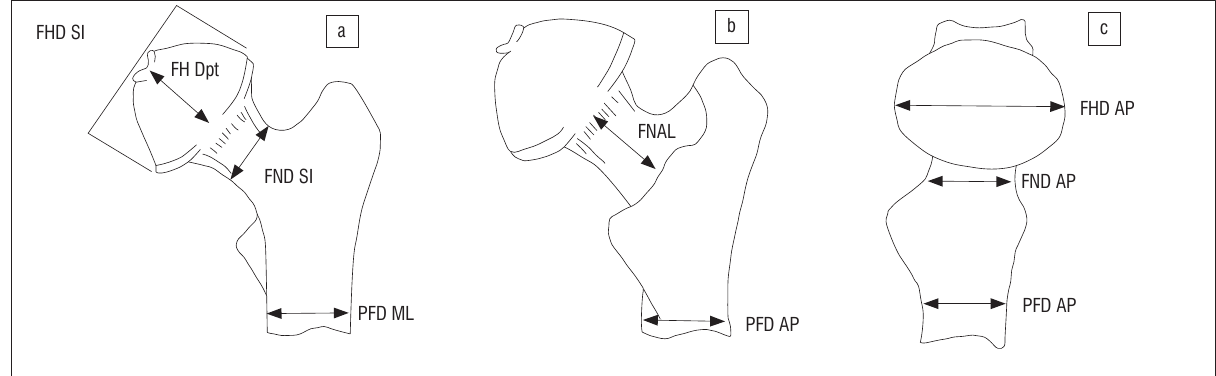
FHD SI/AP, superoinferior/anteroposterior diameter of the proximal articulation; FH Dpt, mediolateral diameter of the proximal articulation; FND SI/AP, superoinferior/anteroposterior diameter of the femoral neck; PFD ML/AP, mediolateral/anteroposterior diameter of the proximal diaphysis (distal to the lesser trochanter); FNAL, anatomical length of the femoral neck. Figure 1: Linear dimensions taken on the proximal femur in (a) anterior, (b) posterior and (c) medial